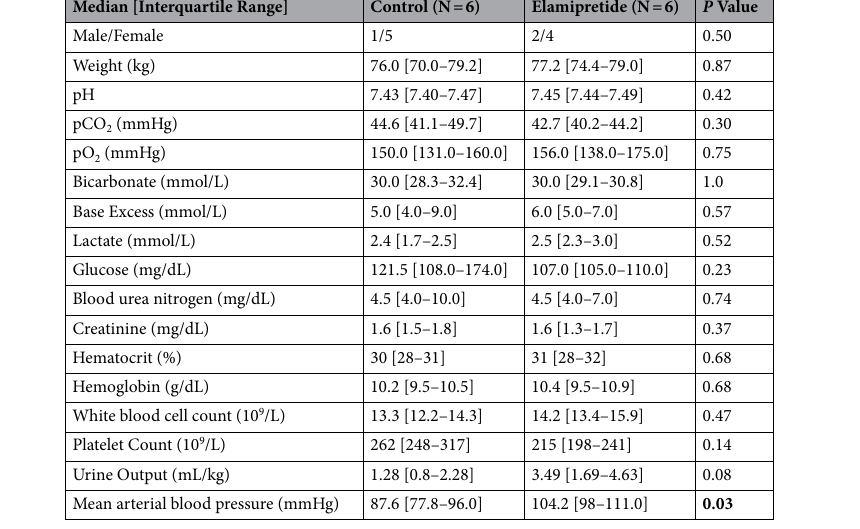
Table 1. Baseline characteristics. Significant values are in bold.